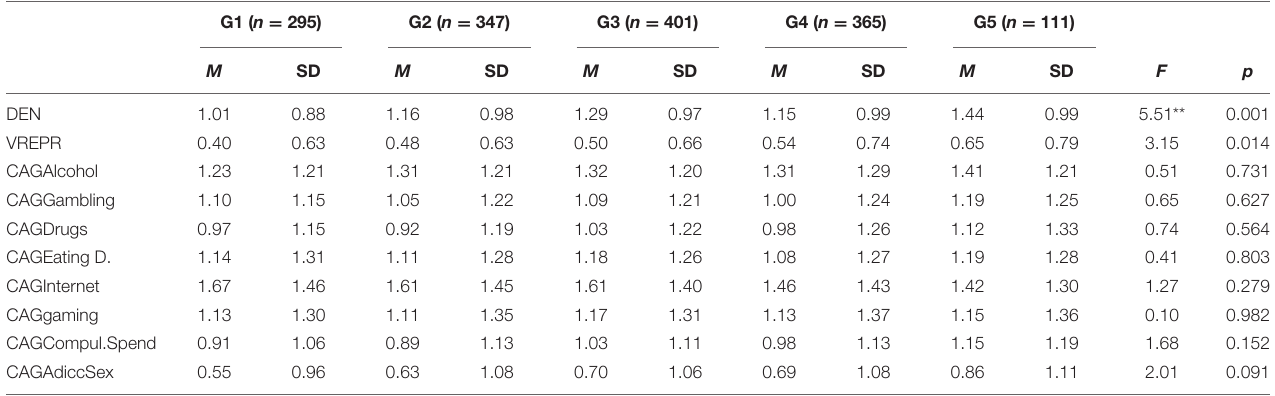
TABLE 2 | Differences in emotional dependence, received violence, and addictive disorders according to age. G1 ( n = 295)